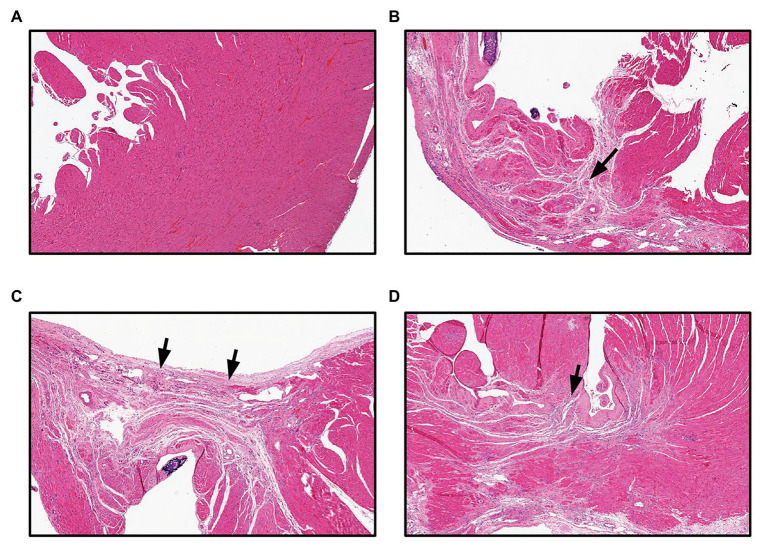
Left ventricular myocardial infarct size (HE staining 2 × 10 times). (A) Sham operation group; (B) control group; (C) sodium creatine phosphate group; and (D) Xinmailong group. Arrows in (B–D) indicate myocardial necrosis.